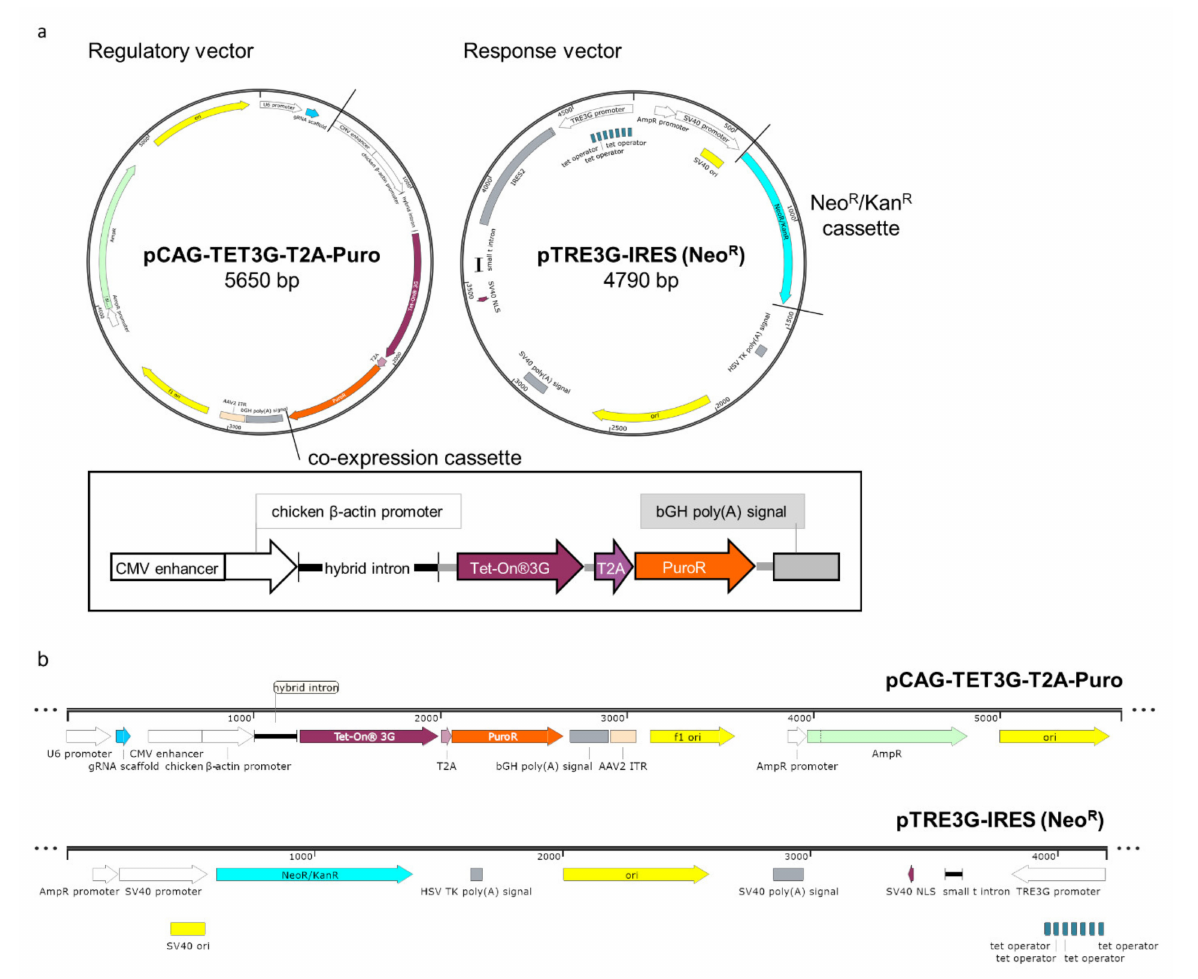
Figure 1. Overview of the redesigned inducible expression system. Genetic maps of regulatory and response vectors with introduced modifications, presented in circular ( a ) and linear ( b ) views, were prepared with SnapGene (SnapGene ® software from GSL Biotech; available at snapgene.com). The re-engineered transactivator system involved the cloning of the chicken β -actin (CAG) promoter (CAGp) upstream the transactivator gene ( TET3G ), followed by T2A and the puromycin (Puro) resistance gene ( PuroR ) to ensure equal co-expression of TET3G and Puro, and is marked on the regulatory vector backbone with black lines and enlarged in the box as a co-expression cassette ( a ). The response vector was modified by cloning a cassette containing the Kan/Neo resistance gene, indicated on the vector backbone with cyan color, under a double promoter (eukaryotic/prokaryotic) ( a , b